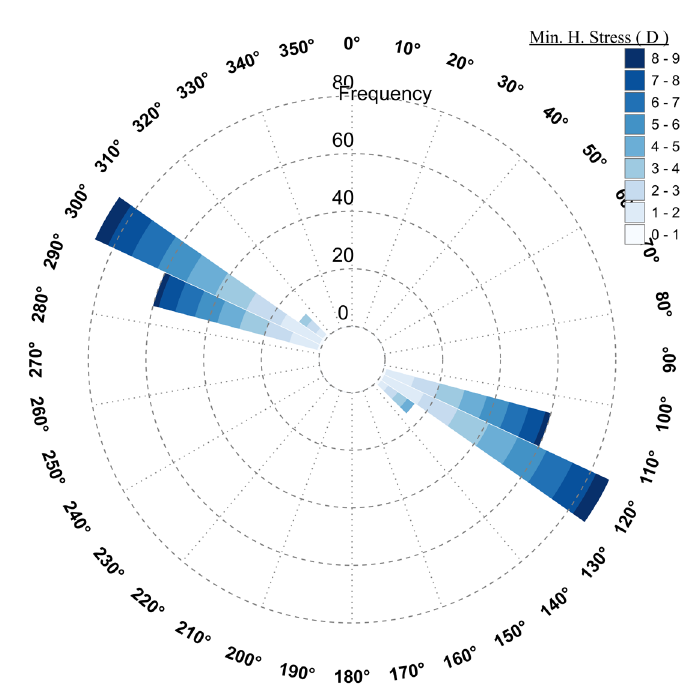
Figure 11. Wellbore-D wall minimum horizontal stress in the Azar oilfield, collapsed in azimuth 120 ◦ and 300 ◦ . This rose diagram result was made with